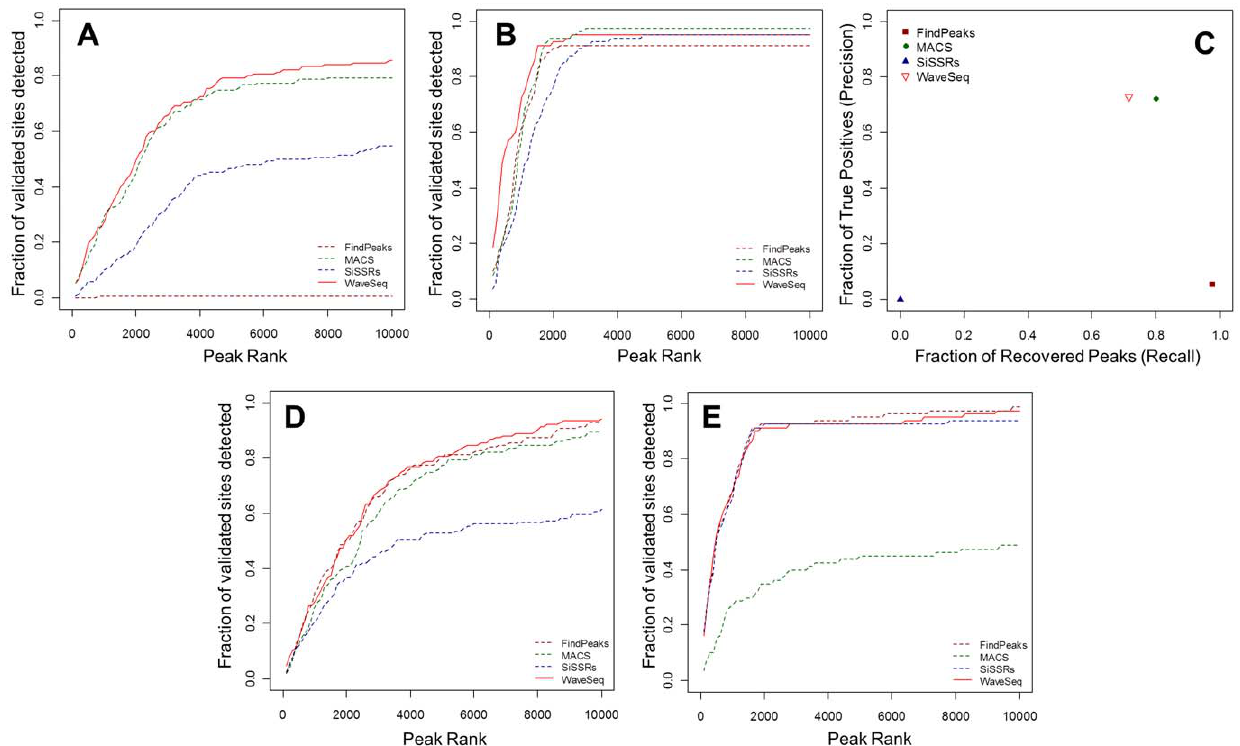
Figure 2. WaveSeq has high sensitivity and precision for punctate data sets. (a & b) Plots of peak ranks against the fraction of validated sites detected by WaveSeq, FindPeaks, MACS and SiSSRs for the (a) GABP and (b) NRSF data sets. WaveSeq has the highest sensitivity for the GABP data set closely followed by MACS, while all methods performed comparably for the NRSF data. (c) A plot of the fraction of true positives (Precision) against the fraction of recovered peaks (recall) for the synthetic spike-in data set shows MACS has the best combination of the two, closely followed by WaveSeq. FindPeaks calls a large number of false positives while SiSSRs fails to detect any peaks. (d & e) Sensitivity plots for the (d) GABP and (e) NRSF data sets shows that WaveSeq has high sensitivity for these data sets even in the absence of control. FindPeaks performs much better on these data sets without control and has almost identical sensitivity as WaveSeq. SiSSRs has mixed results with low sensitivity for GABP and high for NRSF while the reverse is true of